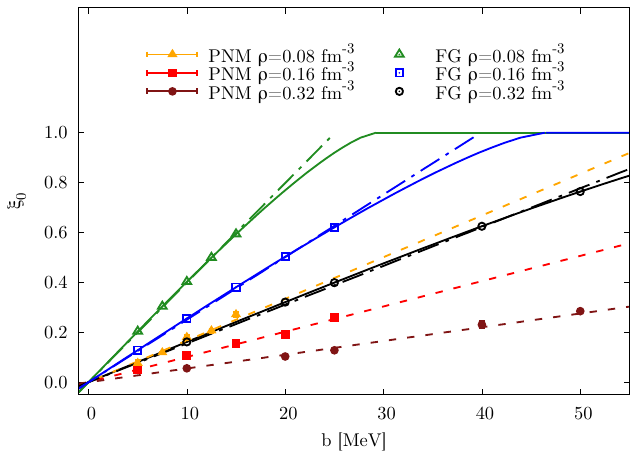
Figure 5. Ground-state polarization ξ 0 as a function of the external magnetic field b . The results for PNM with the AV8 (cid:48) + UIX potential (solid symbols) are compared to those for the free FG (empty symbols) at three different densities. Analytic results for the FG are shown with solid lines, while linear fits to some mock data (generated from the analytic solution of the free FG at five different external magnetic fields b ) are shown with dotted-dashed lines. The results for the interacting system obtained from the quadratic fits of approach (i) are shown with orange-red-brown (from low to high density) dashed